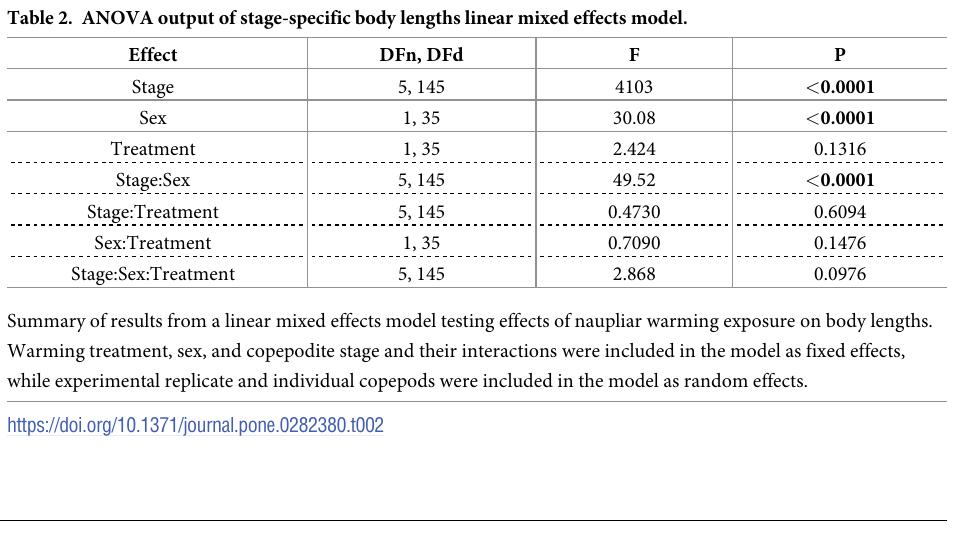
dling on mass-specific respiration rates (p = 0.295, S2 Table in S1 File), body lengths (p = 0.276, S3 Table in S1 File), and copepodite development time (p = 0.092, S4 Table in S1 File).